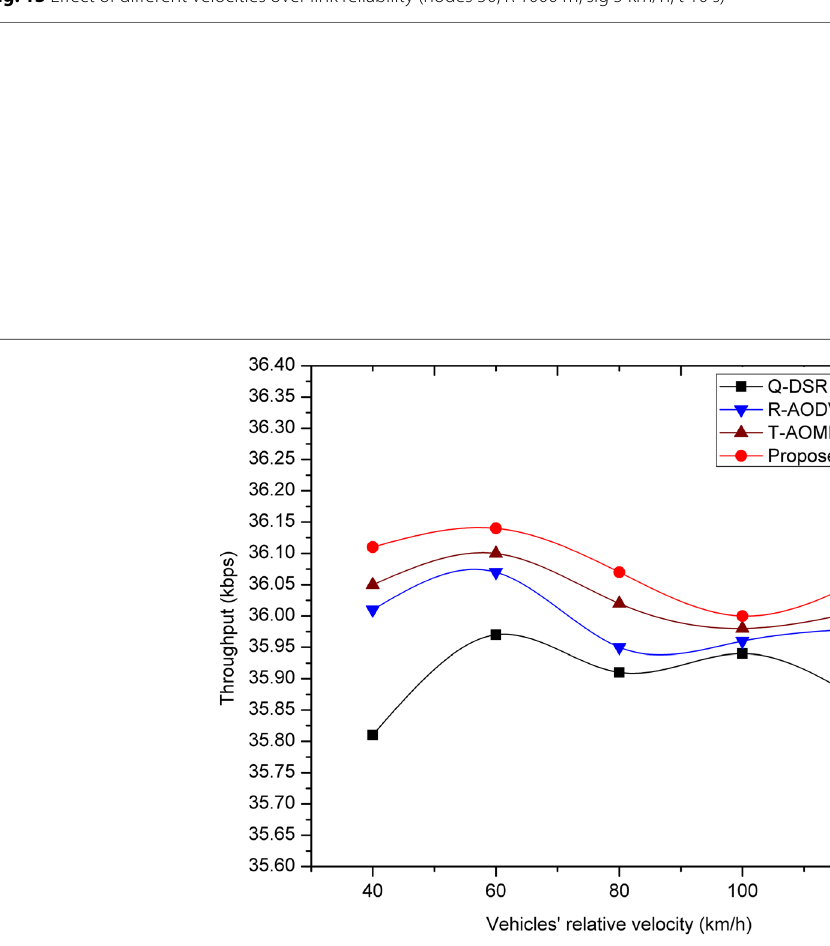
Fig. 13 Effect of different velocities over link reliability (nodes 50, R 1000 m, sig 5 km/h, t 10 s)